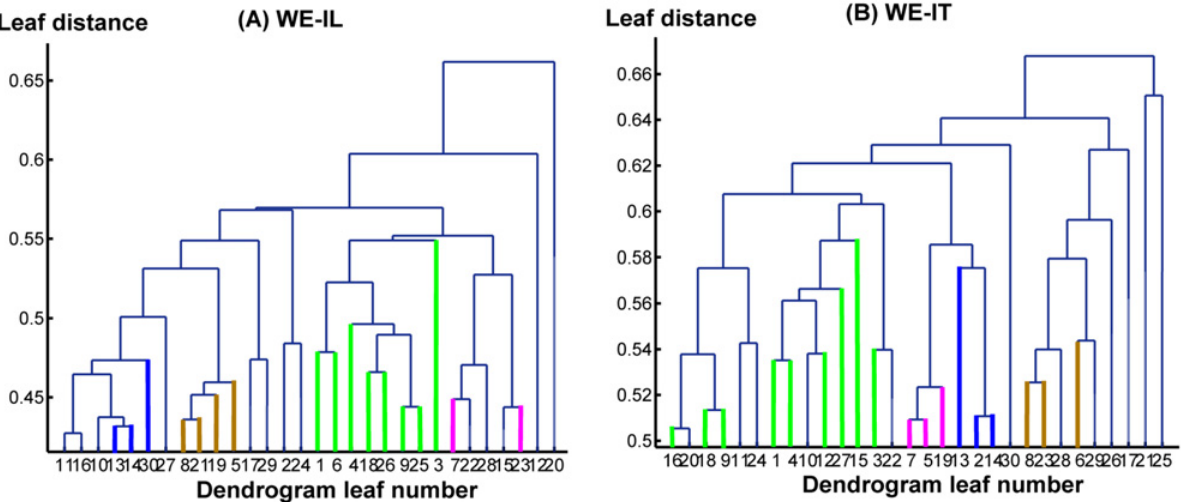
Figure 3. The hierarchy structures based on the dendrogram analysis for the WE-IL (A) and the WE-IT (B) conditions, respectively. The x-axis: leaf number, with each leaf representing a cluster of BAs. The y-axis represents leaf distance calculated using average linkage clustering based on correlation distance. The orange color indicates group A, the blue color indicates group B, the pink color indicates group C, and the green color indicates group D.